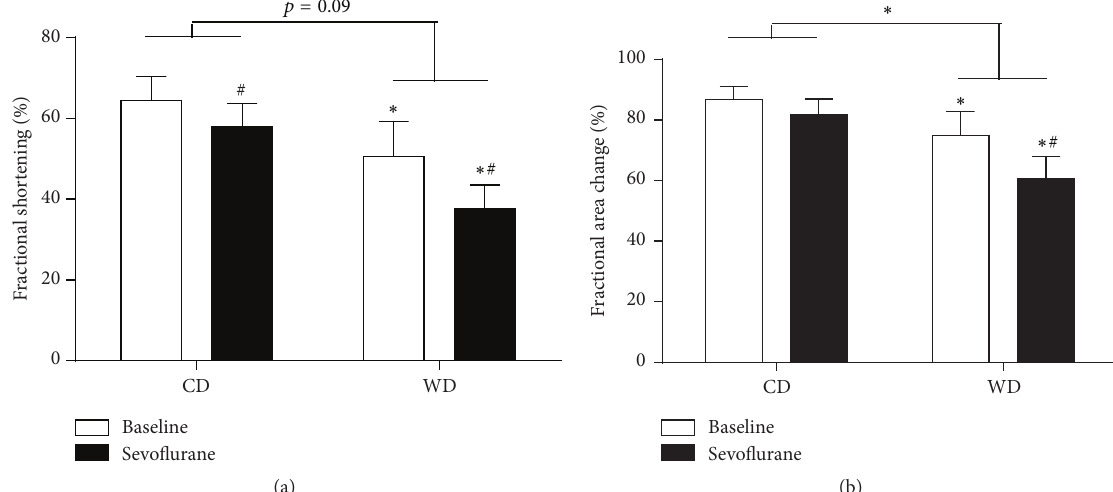
Figure 3: Effect of sevoflurane on systolic function in prediabetic rats. Systolic function, as represented by the fractional shortening (a) and fractional area change (b), measured with echocardiography in rats fed a control diet (CD) or western diet (WD) for 8 weeks during baseline conditions and after 5 minutes of sevoflurane exposure. Data are expressed as mean ± SD, 𝑛 = 9 – 18 ; two-way ANOVA with Bonferroni post hoc analyses, ∗ 𝑝 < 0.05 diet effect, # 𝑝 < 0.05 sevoflurane